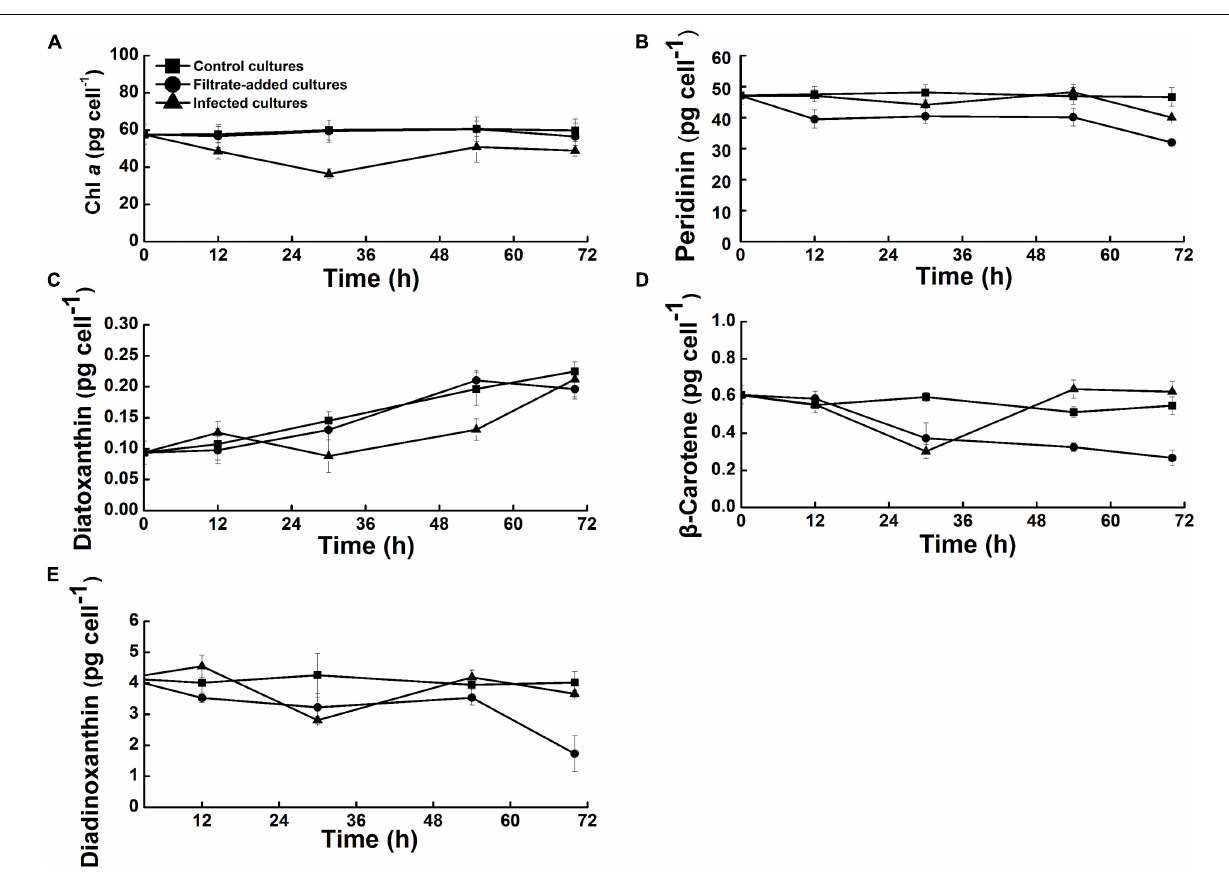
partially be due to indirect contact of host cytoplasmic structures with the growing multinucleate of the parasite once the parasitic infection was established inside host nucleus (Park et al., 2002a).